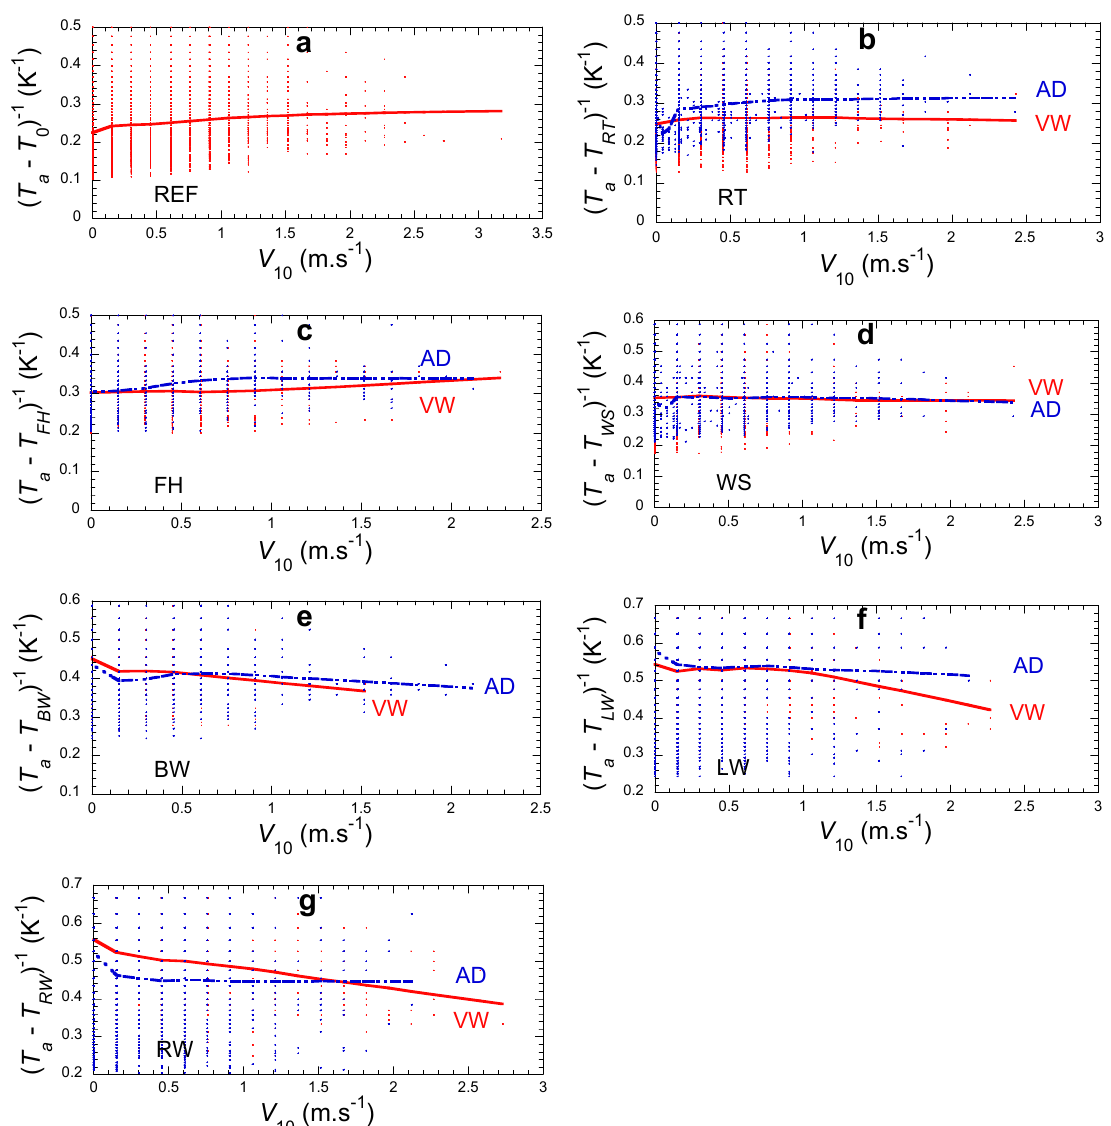
(cid:16) (cid:17) − 1 (cid:2879)(cid:2869) ∝ ∝ a T a − T j j ,